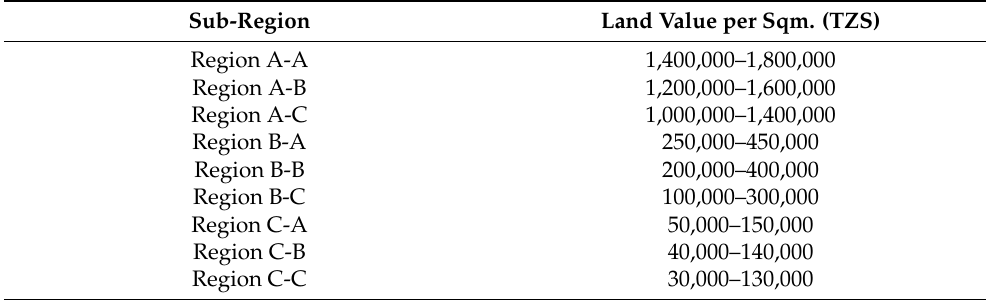
Table 3. Ideal land value table.